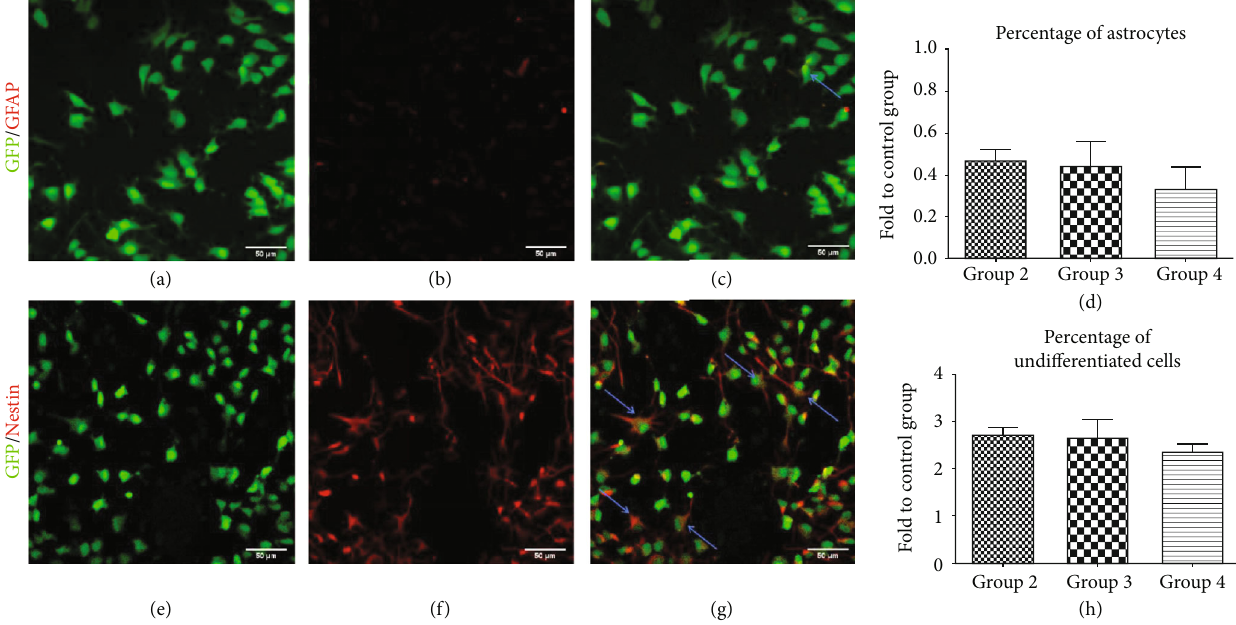
Figure 4: Di ff erentiation of NPCs into astrocytes and quanti fi cation of undi ff erentiated NPCs in vitro . (a-c) Costaining of GFP + /GFAP + cells (blue arrows) indicating astrocytes. (d) Quanti fi cation of astrocytes after 7 days of incubation with the di ff erent growth factor concentrations/combinations in groups 2-4, expressed in proportion to (fold to) the control group (group 1). (e-g) Costaining of GFP + /Nestin + cells (blue arrows) indicating undi ff erentiated NPCs. (h) Quanti fi cation of undi ff erentiated NPCs after 7 days of incubation with the di ff erent growth factor concentrations/combinations in groups 2-4, expressed in proportion to (fold to) the control group (group